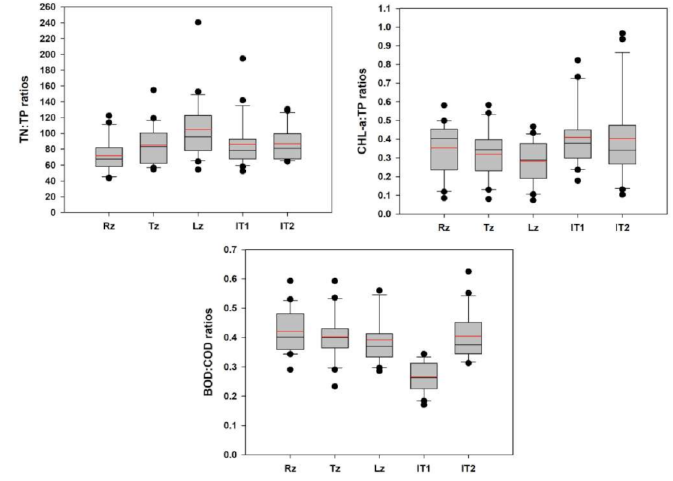
Figure 9. Dynamics of nutrients, algal chlorophyll-a, and organic pollutant ratios in longitudinal zones of Daecheong Reservoir. TN: total nitrogen; TP: total phosphorus; CHL-a: chlorophyll-a; BOD: biological oxygen demand; COD: chemical oxygen demand; Rz: riverine zone; Tz: transitional zone; Lz: Lacustrine zone; IT1 and IT2: intake tower of drinking water 1 and 2; red lines in the box indicate mean values.